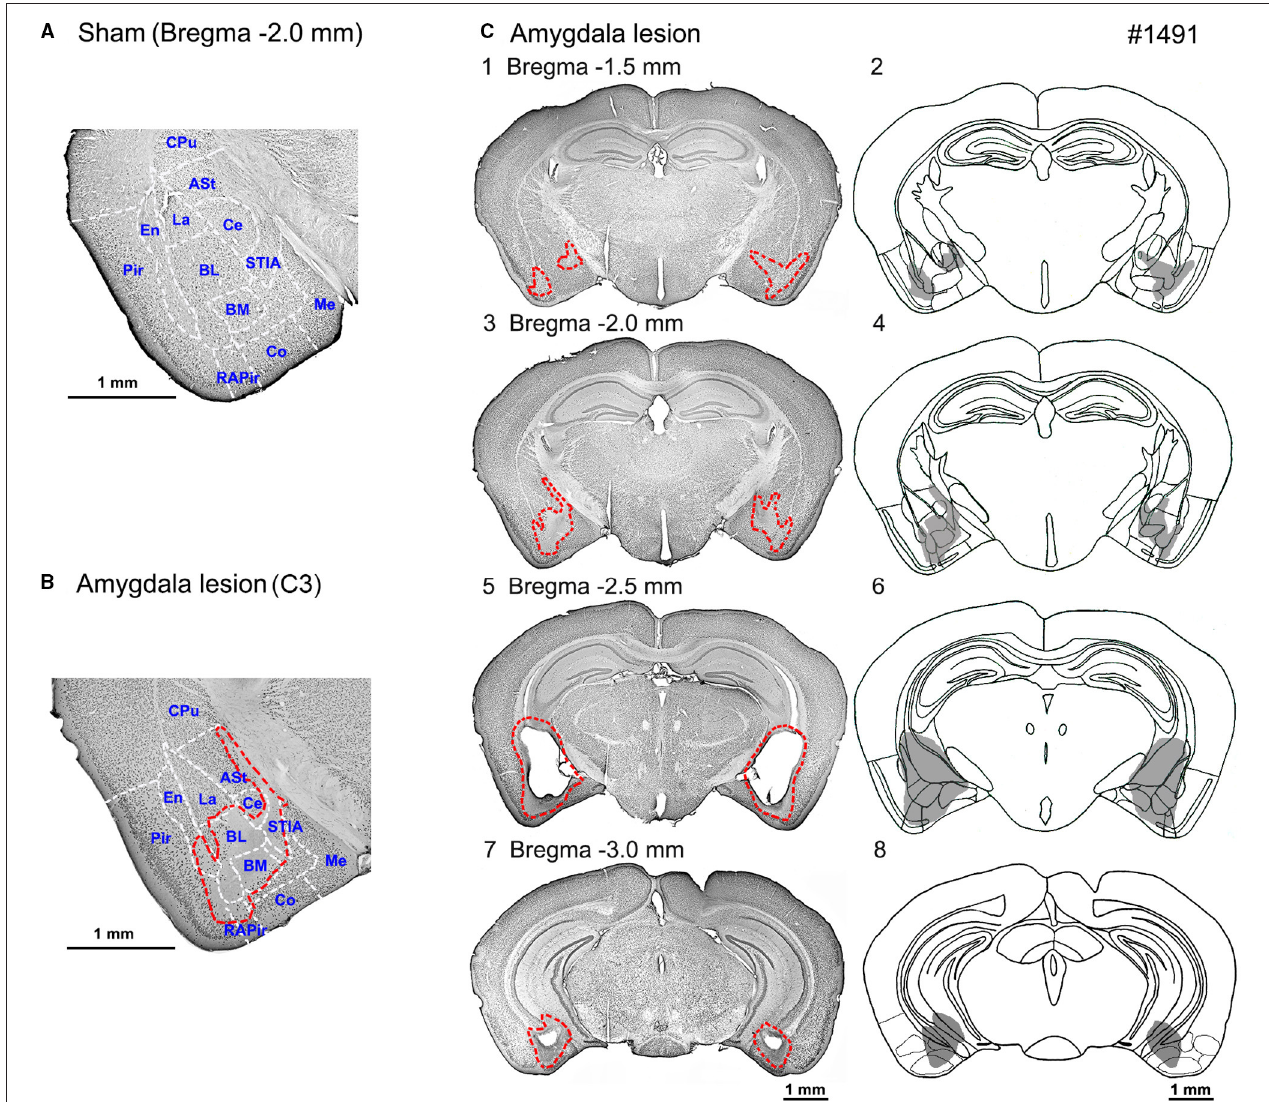
FIGURE 2 | Photomicrographs and schematic diagrams of the frontal sections of mouse brains showing lesion extents in bilateral amygdala induced by the ibotenic acid injections. (A) A photomicrograph of the frontal section of amygdala slice (Bregma − 2.0mm) in a sham-lesioned mouse. (B) A photomicrograph of the frontal section of the amygdala (Bregma − 2.0mm) shows lesion extent (red dot line). (C) Photomicrographs (left panel; C1, C3, C5, C7 ) and schematic diagrams (right panel; C2, C4, C6, C8 ) of the serial frontal sections (Bregma − 1.5 to − 3.0mm) showing the lesion extents (red dot line or gray area, respectively) in mouse No. 1491. ASt, amygdalostriatal transition area; BL, basolateral amygdaloid nucleus; BM, basomedial amygdaloid nucleus; Ce, central amydaloid nucleus; Co, cortical amygdaloid nucleus; CPu, caudate putamen (Striatum); En, endopiriform claustrum; La, lateral amygdaloid nucleus; Me, medial amygdaloid nucleus; Pir, piriform cortex; RAPir, rostral amygdalopiriform area; STIA, bed nucleus of the stria terminalis, intraamygdaloid division.